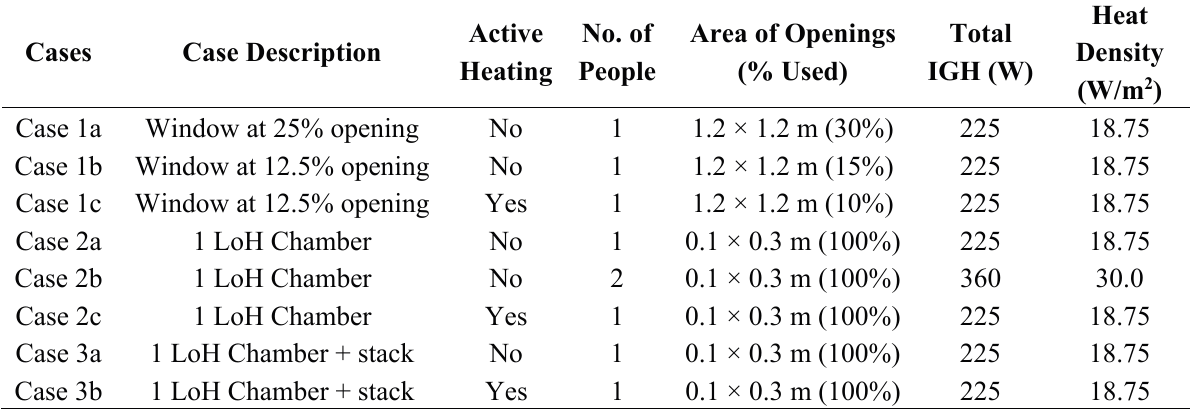
Table 1. Description of six cases simulated via dynamic thermal modelling (DTM) application.